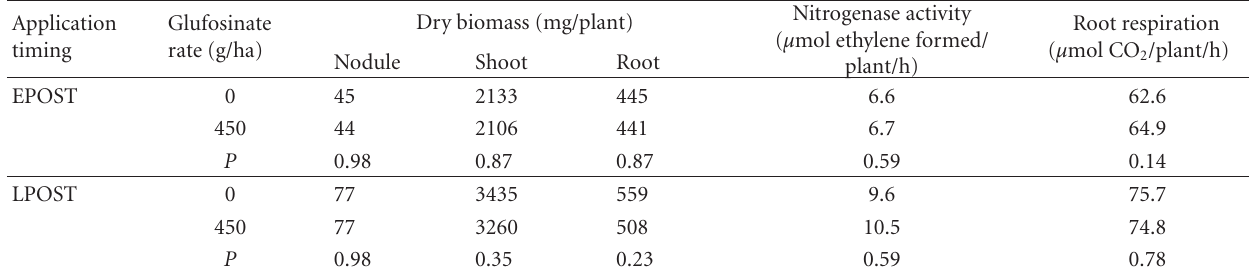
Table 2: Glufosinate e ff ect on shoot, root, and nodule biomass, nitrogenase activity, and root respiration in glufosinate-resistant soybean under field conditions in 2009 and 2010. Data represent the mean of 3 and 12d after early postemergence application in 2009 and